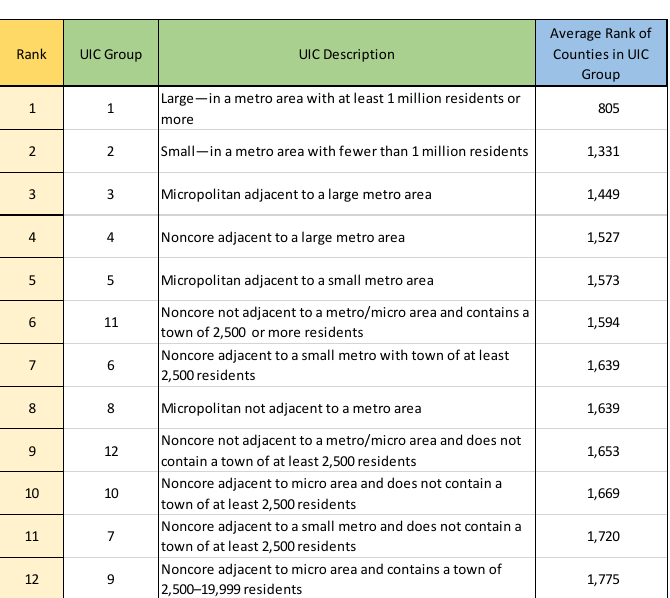
Table 17. UIC Group Ranking: Female Principal Operator, 2012